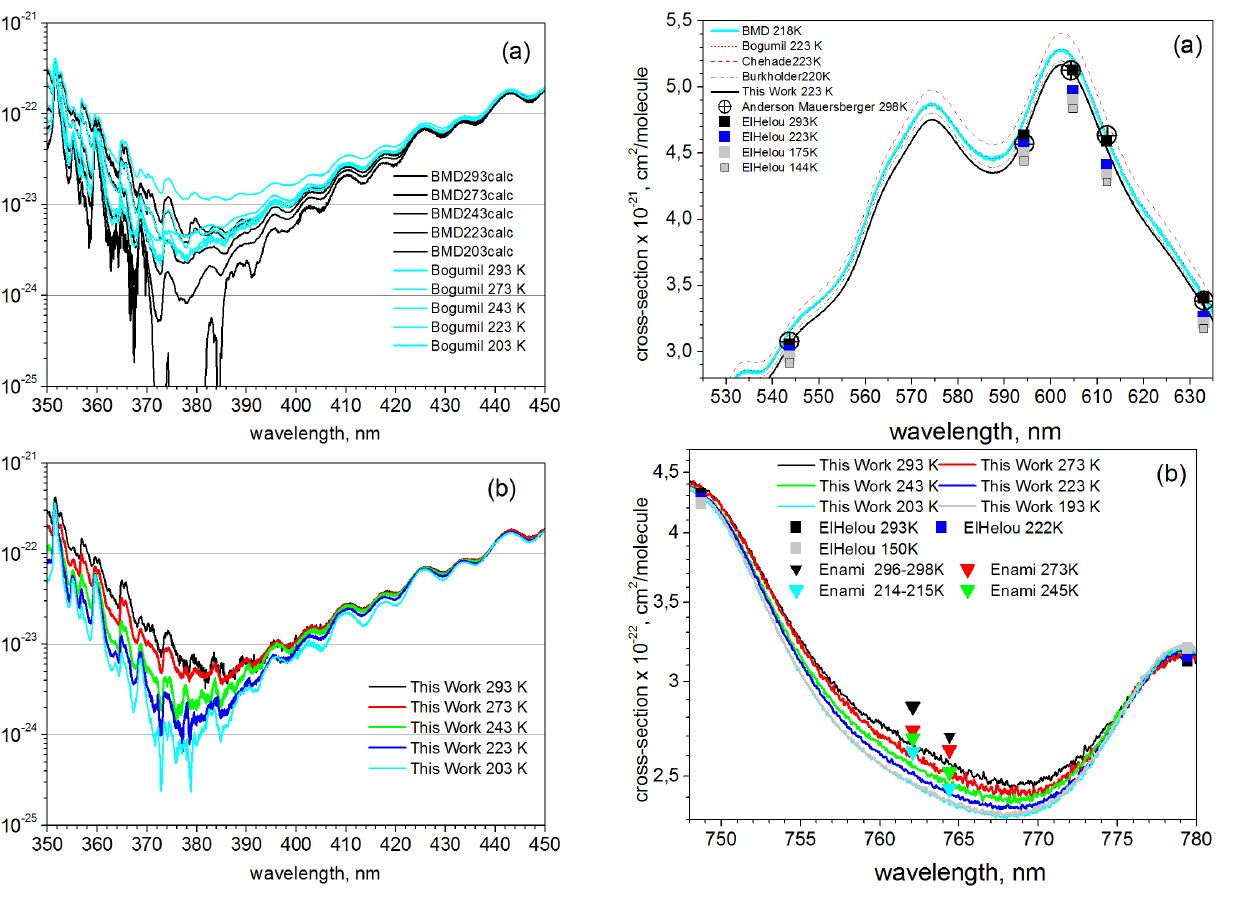
Fig. 8. Ozone cross-sections in the Chappuis and Wulf bands at different temperatures: (a) near maximum of the Chappuis band (squares – El Helou et al. (2005); circles – Anderson and Mauersberger (1992); red dashed line – Bogumil et al. (2003) and Chehade et al. (2013); light-blue solid lines – BMD; dash-dot line – Burkholder and Talukdar (1994); black solid lines – this work); (b) near 760nm (squares – El Helou et al. (2005); triangles – Enami et al. (2004); lines – this